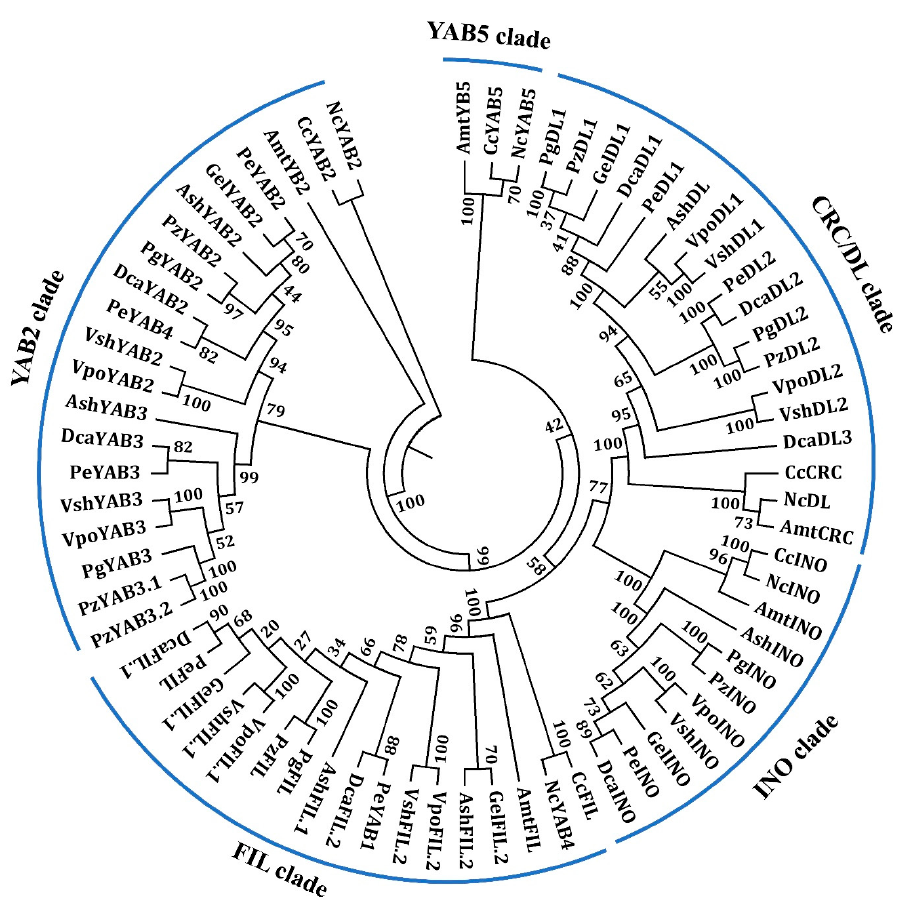
Figure 3. Phylogenetic tree of YABBY proteins from Amborella trichopoda , Cabomba caroliniana , Nymphaea colorata , and different types of orchids. The phylogenetic tree was constructed with the neighbor-joining (NJ) method in MEGA 6.0 software and was divided into five subgroups. A bootstrap analysis was conducted with 1000 replications. Gel, Gastrodia elata ; Vpo, Vanilla planifolia ; Pe, Phalaenopsis equestris ; Vsh, Vanilla shenzhenica ; Pg, Platanthera guangdongensis ; Pz, Platanthera zijinensis ; Dca, Dendrobium catenatum ; Ash, Apostasia shenzhenica ; Amt, Amborella trichopoda ; Cc, Cabomba caroliniana ; and Nc, Nymphaea colorata . The protein accession numbers for the related proteins are listed in Supplementary Table